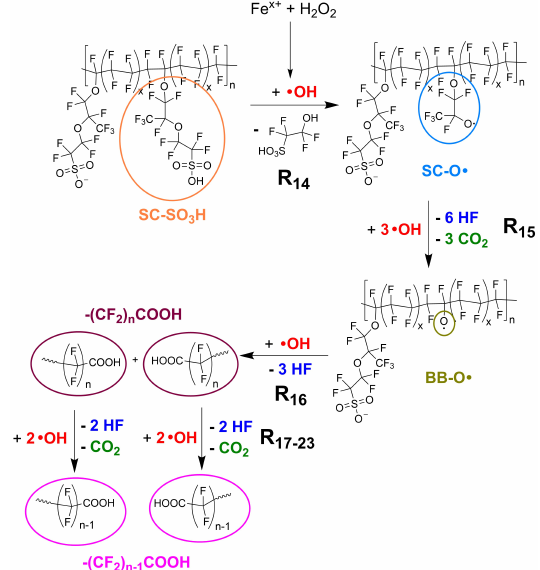
Figure 1. Side chain degradation mechanism used in the present kinetic framework [23–25]. SC stands for side chain and BB for backbone. Additional chemical species involved in the reactions R 15 –R 23 (e.g., H 2 O) are omitted for reasons of clarity. The kinetic data for the reactions are given in Table 1. For further explanation see ref.